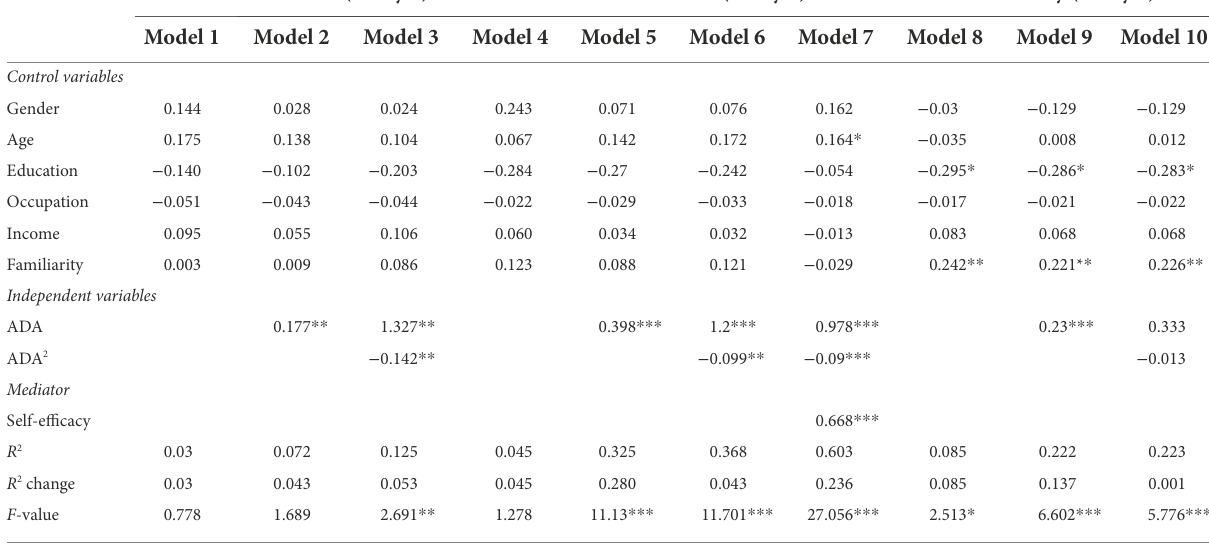
TABLE 1 Regression results.